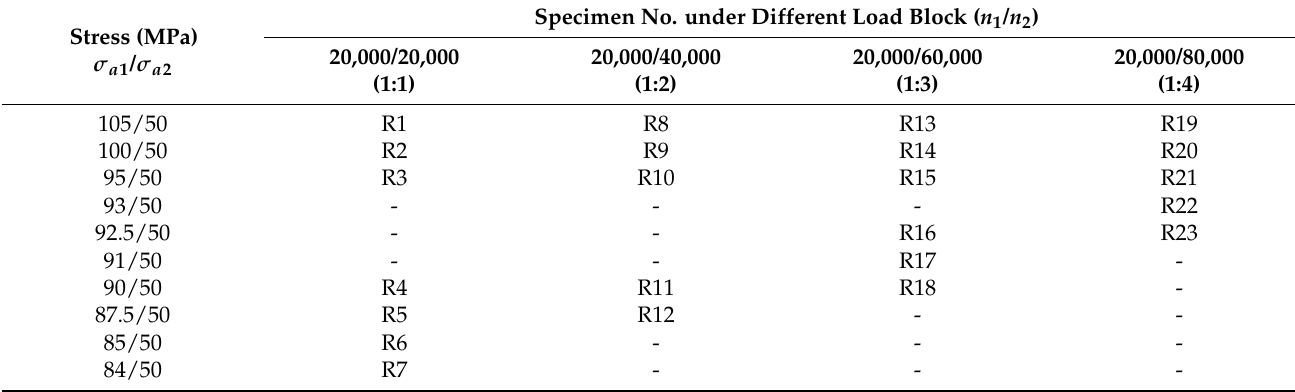
Table 5. Test loading conditions of the two-step repeating amplitude.